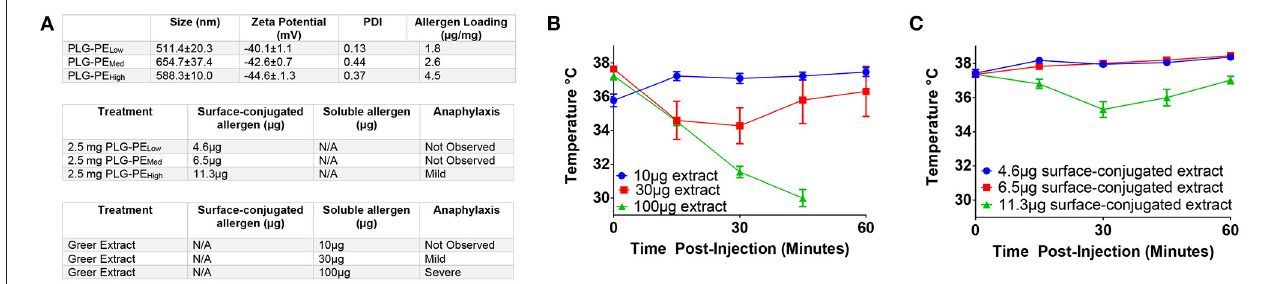
FIGURE 1 | Determination of safety parameters related to delivery of peanut extract via NP. C3H/HeJ mice were sensitized with i.p. injection of peanut and alum at Day − 14 and 0. Mice received injection of either peanut extract in PBS or peanut extract surface-conjugated to PLG on Day + 7 and were assessed for anaphylaxis as measured by core temperature. (A) Antigen loadings (by BCA assay) for each formulation are listed in µ g of peanut extract per mg of nanoparticle ( µ g/mg). Surface-conjugated NP (PLG-PE) were generated with low (1.8 µ g/mg), medium (2.6 µ g/mg), or high (4.5 µ g/mg) loadings of peanut extract. Relative amounts of surface or soluble peanut extract were delivered intravenously and the corresponding observation of anaphylactic response was recorded. (B) Core temperatures of mice receiving intravenous injection of peanut extract in PBS (i.e. nanoparticle-free). (C) Core temperature of mice receiving intravenous injection of peanut extract surface-conjugated to PLG nanoparticles. Plots display mean measurement ± SEM. n = 4–5 per treatment